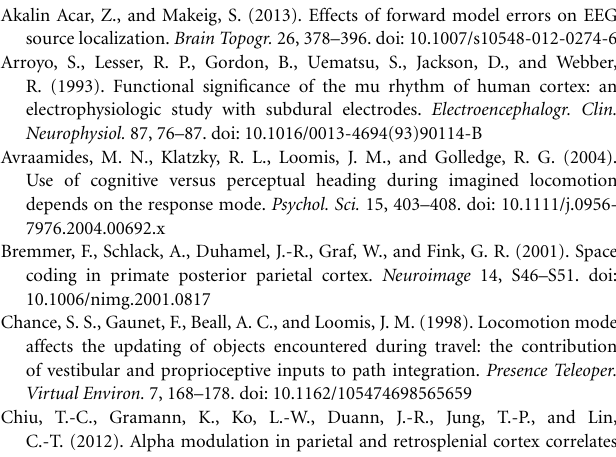
Supplementary Figure S1 | Starfield and guiding object. Subjects followed a small, spherical guiding object (blue) indicating the predefined path and turn. The starfield consisted of randomly distributed dots (red), which faded out within 20m viewing distance. Supplementary Figure S2 | Response arrow during answer